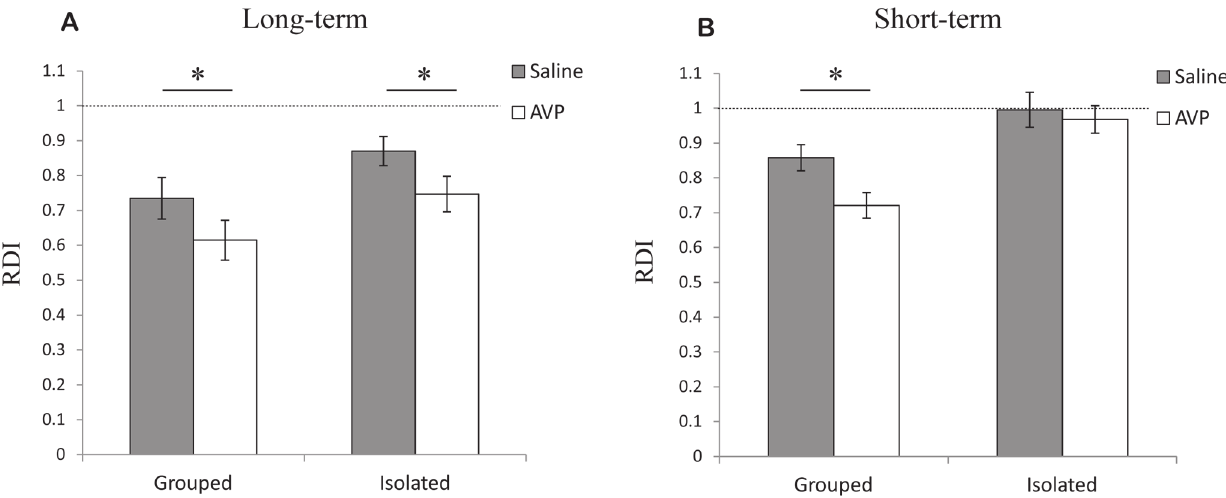
Figure 5. Arginine-vasopressin (AVP) administration affected the impairment induced by social isolation in long-, but not in short- term SRM (mean ± SEM). A) RDI values of two 5 min encounters with the same juvenile 120 min apart. Male rats from group housing (left, n=11) and socially isolated rats (right, n=20) were given either saline (grey bars) or AVP (empty bars) subcutaneously 1 min after the first encounter. In both housing conditions AVP administration significantly reduced the RDI compared to saline administration, showing SRM improvement. Paired t-test: * p , 0.05. B) RDI values of two 2 min encounters with the same juvenile 60 min apart. Male rats from group housing (left, n=7) and socially isolated rats (right, n=8) received either saline (grey bars) or AVP (empty bars) subcutaneously as above. In contrast to long-term SRM (a), AVP administration significantly improved short-term SRM compared to saline administration only in rats from group housing. No improvement was observed in socially isolated animals. Paired t-test: * p ,